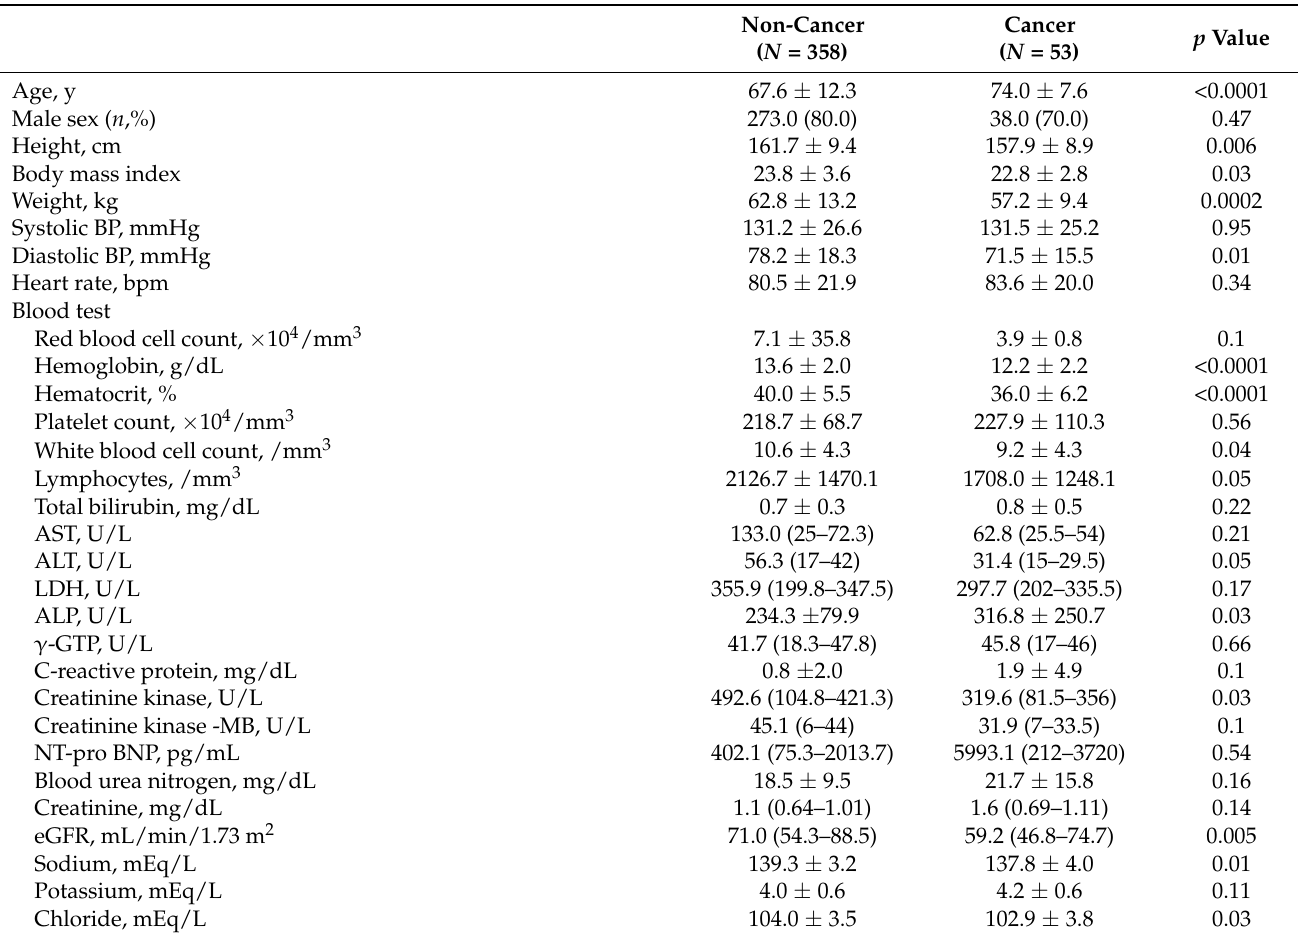
Table 1. Clinical characteristics of acute myocardial infarction patients with and without cancer.